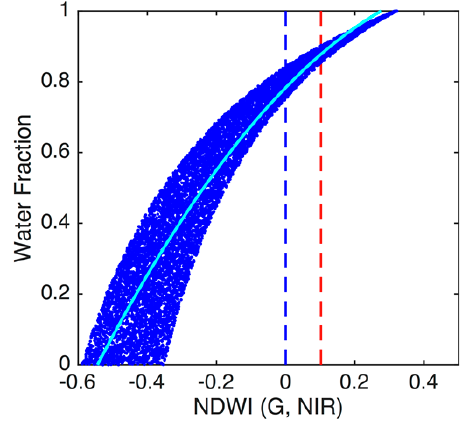
Figure 5 . NDWI regression of the band combination: Green and near infrared. Zero threshold (blue dash) and Otsu’s threshold (red dash) illustrated (Niroumand-Jadidi and Vitti,